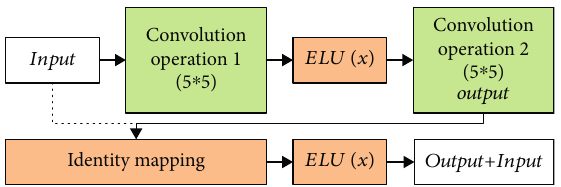
Figure 3: Residual identity